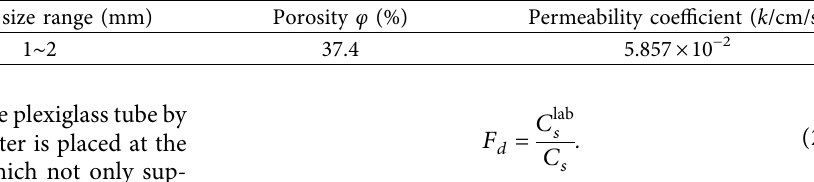
Table 1: Physical and mechanical parameters of sand-injected